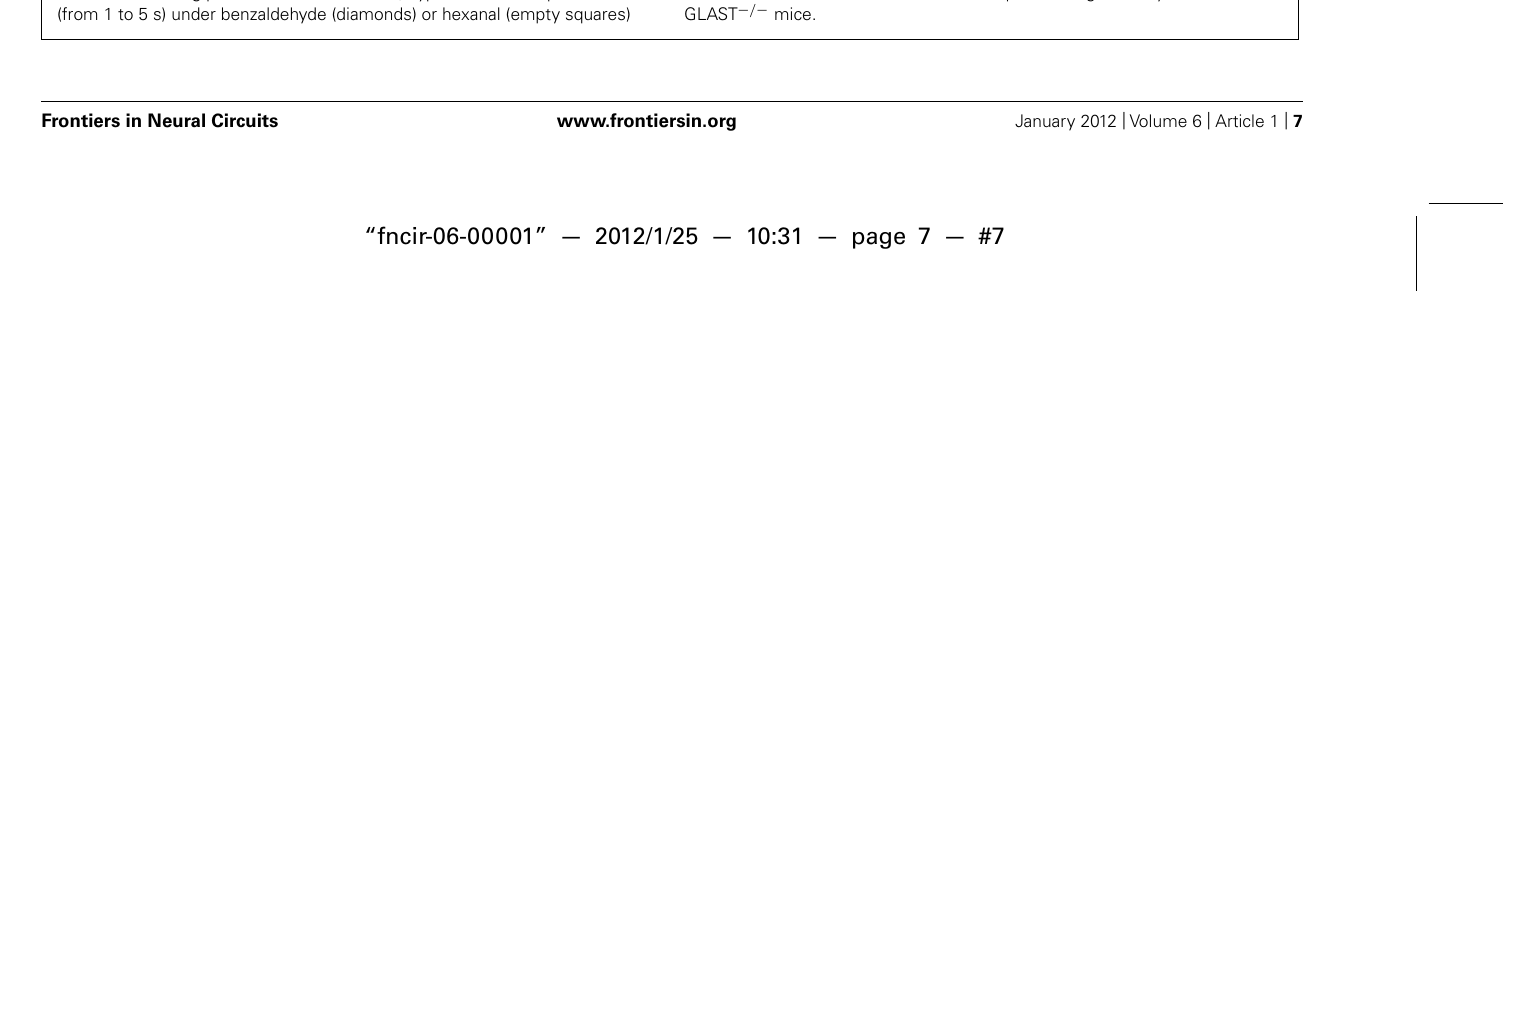
FIGURE 4 | Effects of odor stimulation on beta (15–35 Hz) and gamma (60–160 Hz) oscillations in GLAST + / + and GLAST − / − mice. (A) Representative single trial showing the switch of oscillations during odor presentation (vertical bar, hexanal 2%) in a GLAST + / + (left column) and GLAST − / − (right column) mice. Top traces : beta (15–35 Hz) filtered; bottom traces : gamma (60–160 Hz) filtered LFPs. (B) Signal represented for one mouse from each group as a time ( x -axis)–frequency ( y -axis) decomposition between 2 and 35 Hz (beta band, bottom) and 60–160 Hz (gamma band, top) after processing of raw signals shown in (A) . The four plots are set to the same scale for power (color bar).White vertical lines indicate odor onset. (C) Individual peaks extracted in the gamma band (60–160 Hz) during pre-odor (from –8 to –4 s; hyphen) and odor period (from 1 to 5 s) under benzaldehyde (diamonds) or hexanal (empty squares)